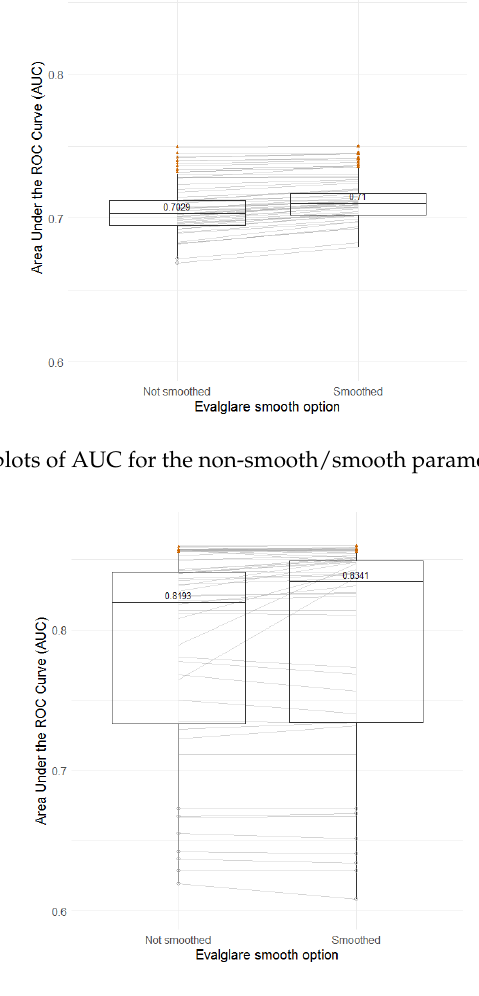
Figure 36. Boxplots of AICc for the non-smooth/smooth parameter (field study).